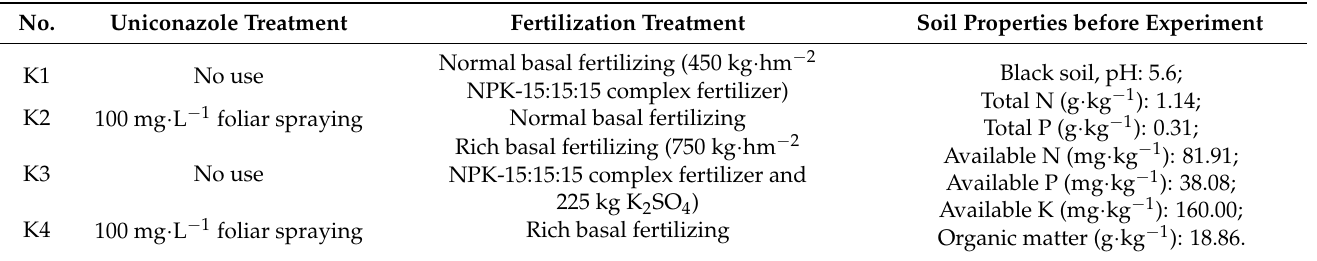
Table 1. Uniconazole spraying and fertilization treatment